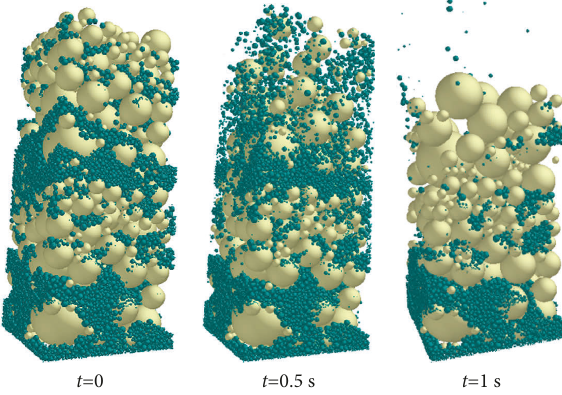
Figure 3: Particle movement at different